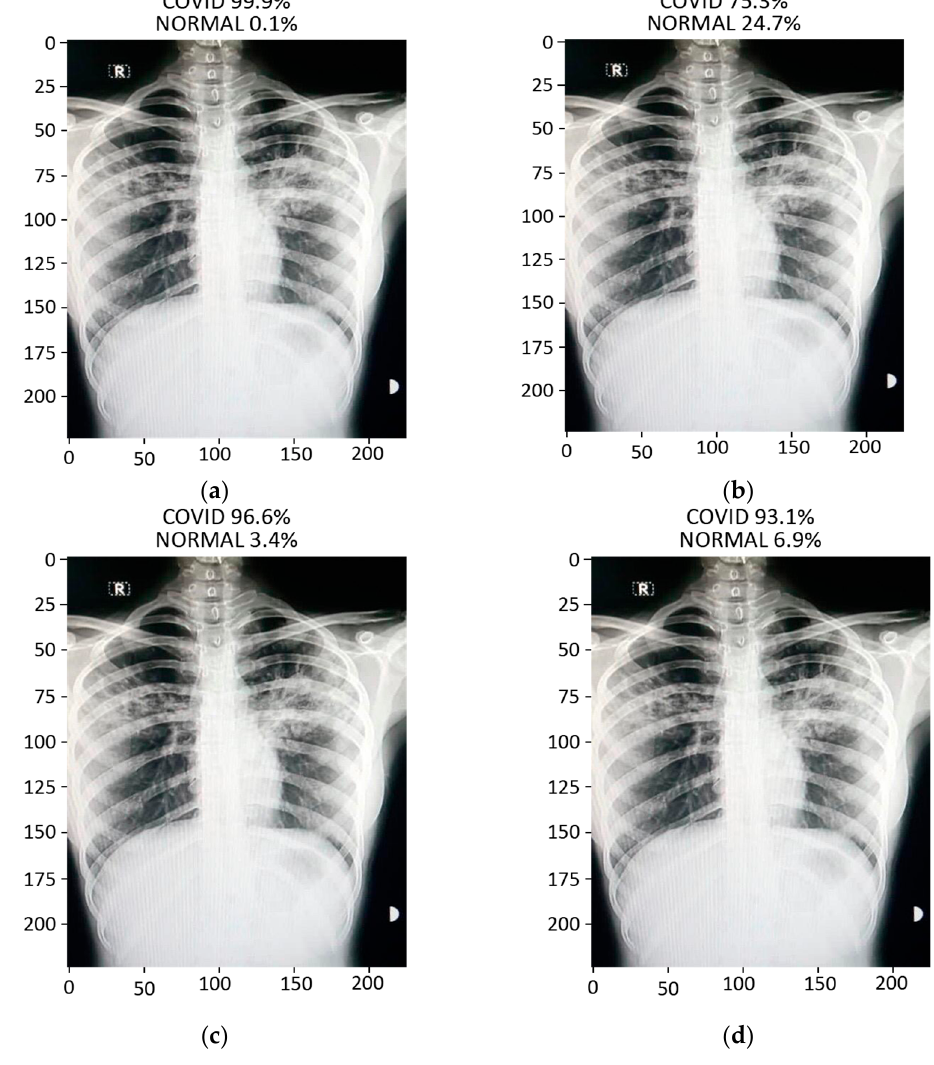
Figure 13. Results of prediction on a verified local Pakistani COVID-19 chest X-ray: ( a ) DenseNet-121; ( b ) VGG16; ( c ) MobileNet; ( d ) ResNet-50.